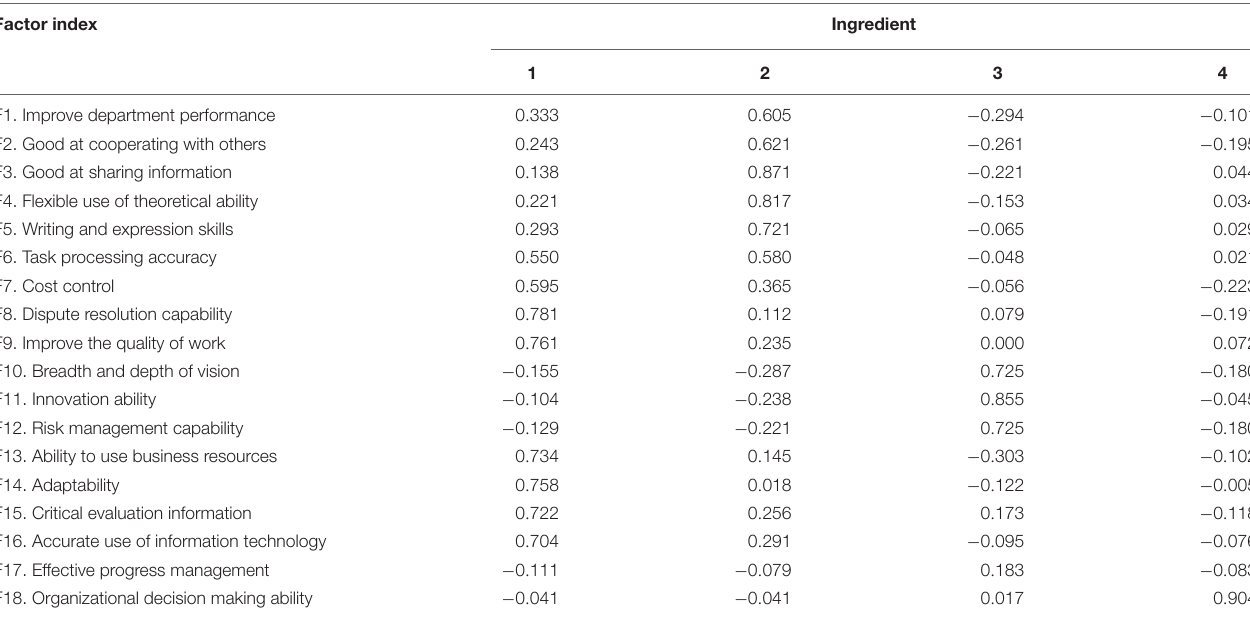
TABLE 1 | Statistics of mean value and standard deviation of 18 index